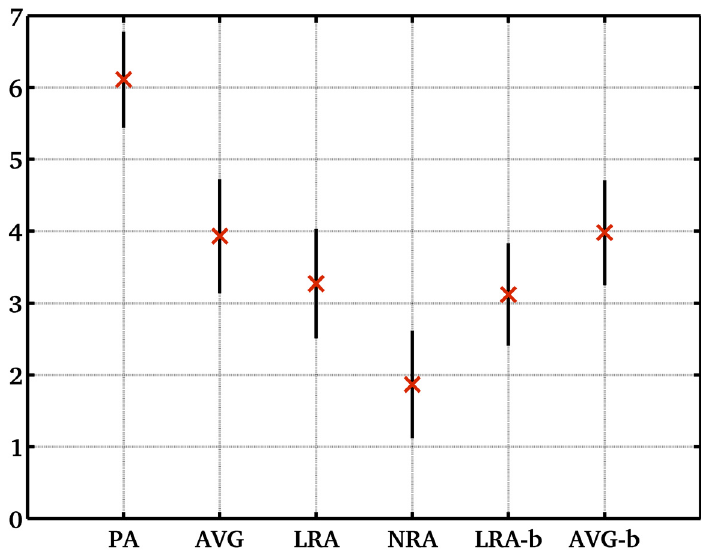
Fig 5. Mean ADC average reproducibility (%) within population for different methods. The within population average reproducibility (based on percentage change in mean ADC figures for different volunteers and methods as given in Table 3); methods include protocol A and the corresponding average slice using protocol B with and without motion correction; error bars show accuracy of each value).